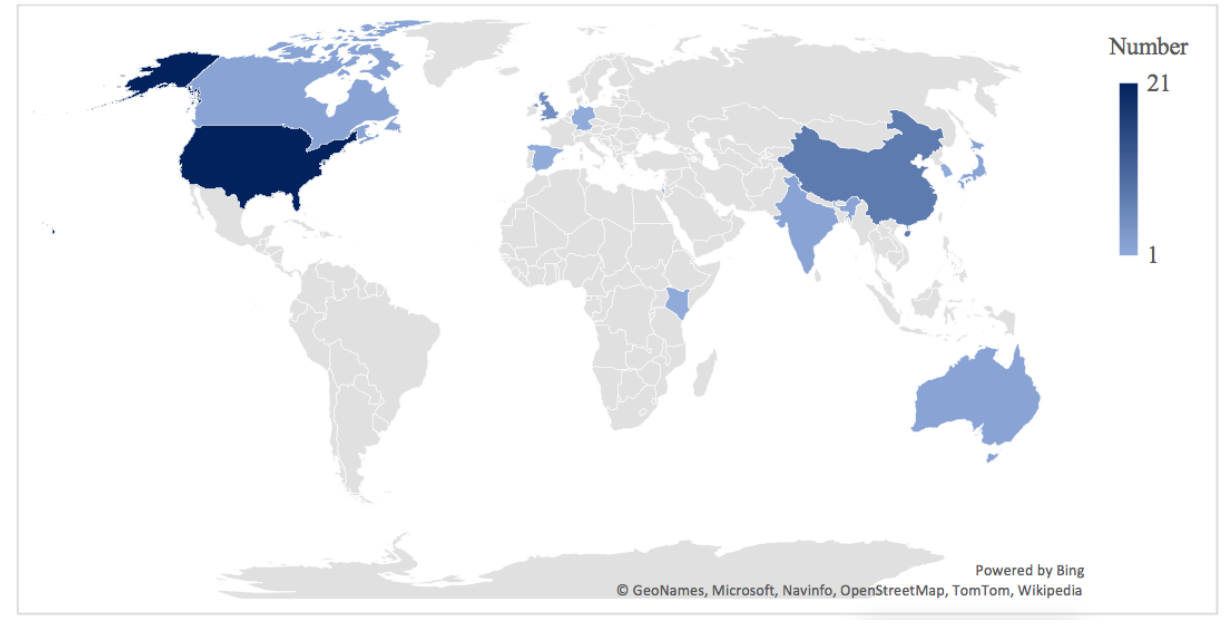
Figure 3. Country distribution of the involved